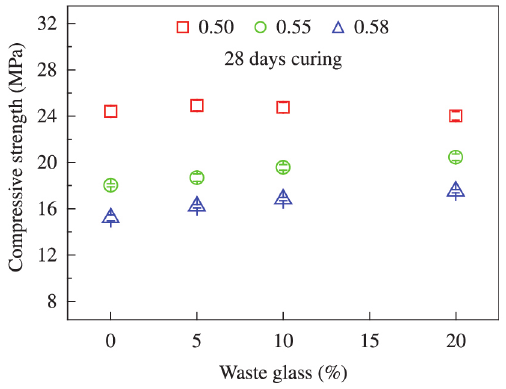
Figure 7. Compressive strength as a function of glass percentage after 28 days of curing.